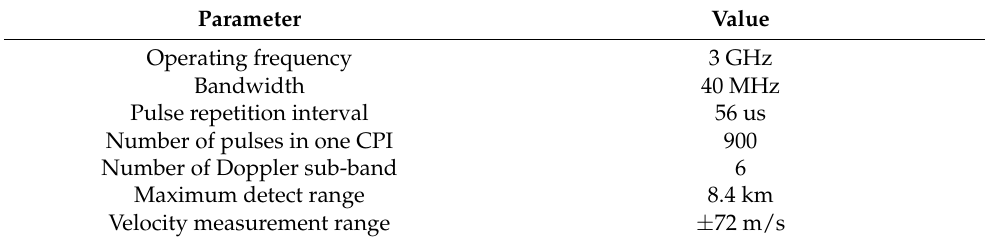
Table 1. Radar parameters.